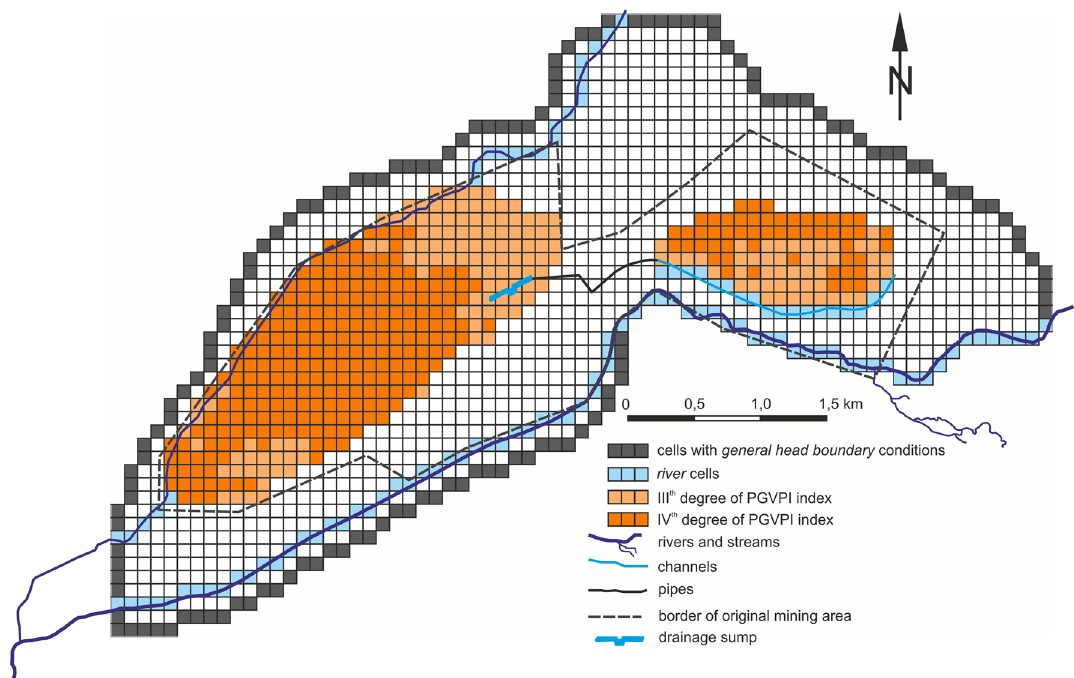
Fig. 7 Map of the distribution of the groundwater vulnerability index for PGVPI pollution in the area of the sand pit reclaimed by Carboniferous gangue